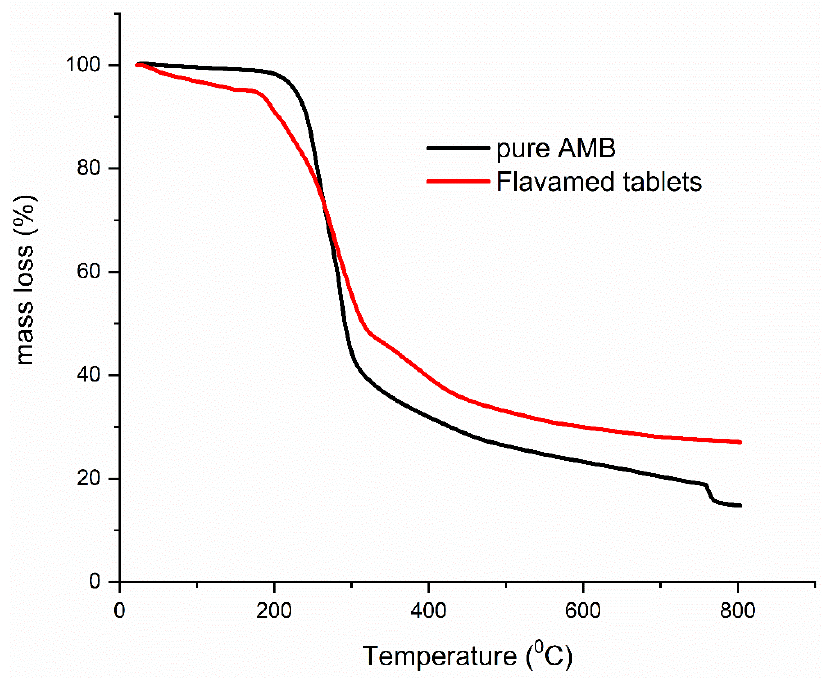
Figure 7. The TG curve of AMB (black line) and FT (red line) at 10 °C · min −1 in N 2 atmosphere